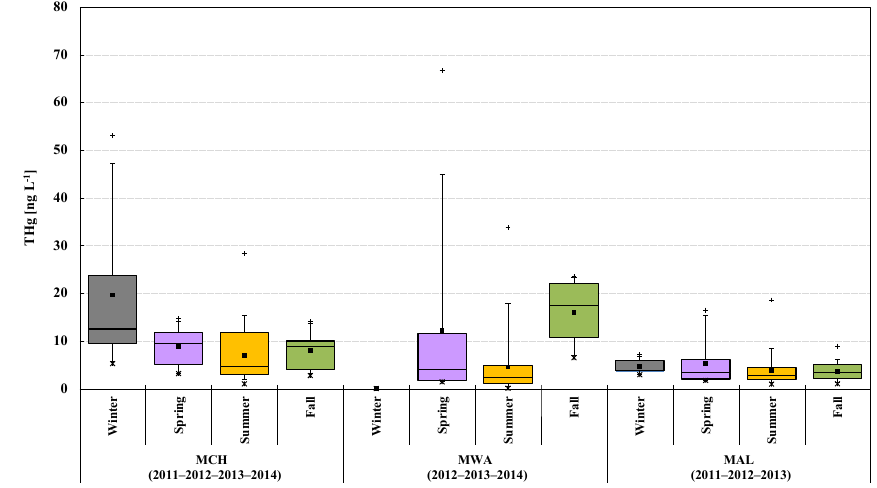
Figure 6. Seasonal distribution of volume-weighted THg concentration in precipitation at the three Chinese GMOS sites from 2011 to 2014. Each box includes the median (midline), mean ( (cid:4) ), 25th and 75th percentiles (box edges), 5th and 95th percentiles (whiskers), minimum ( ∗ ), and maximum ( + ).